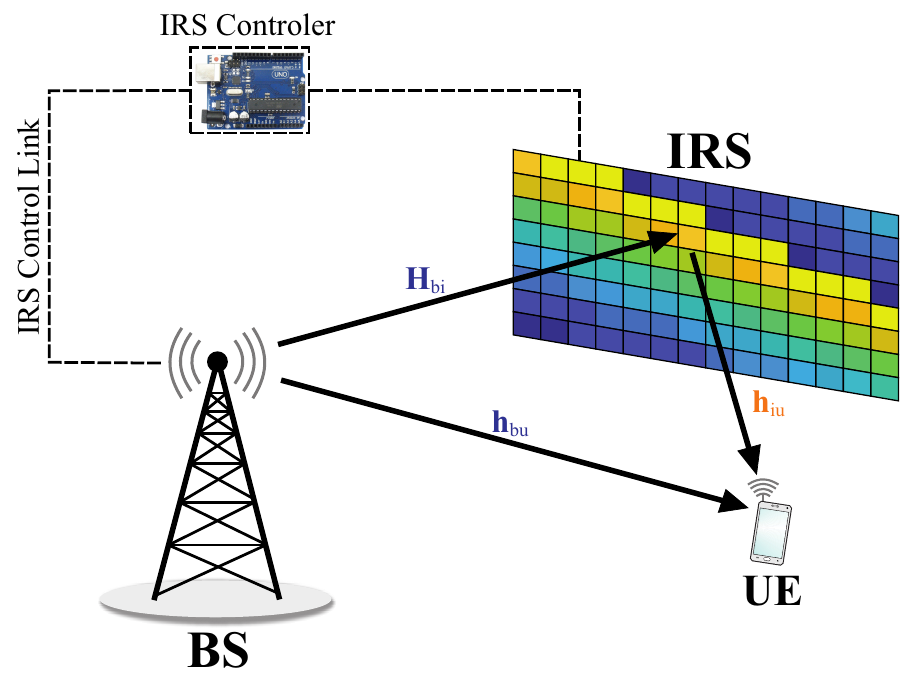
Figure 1. An IRS-assisted single-user downlink communication